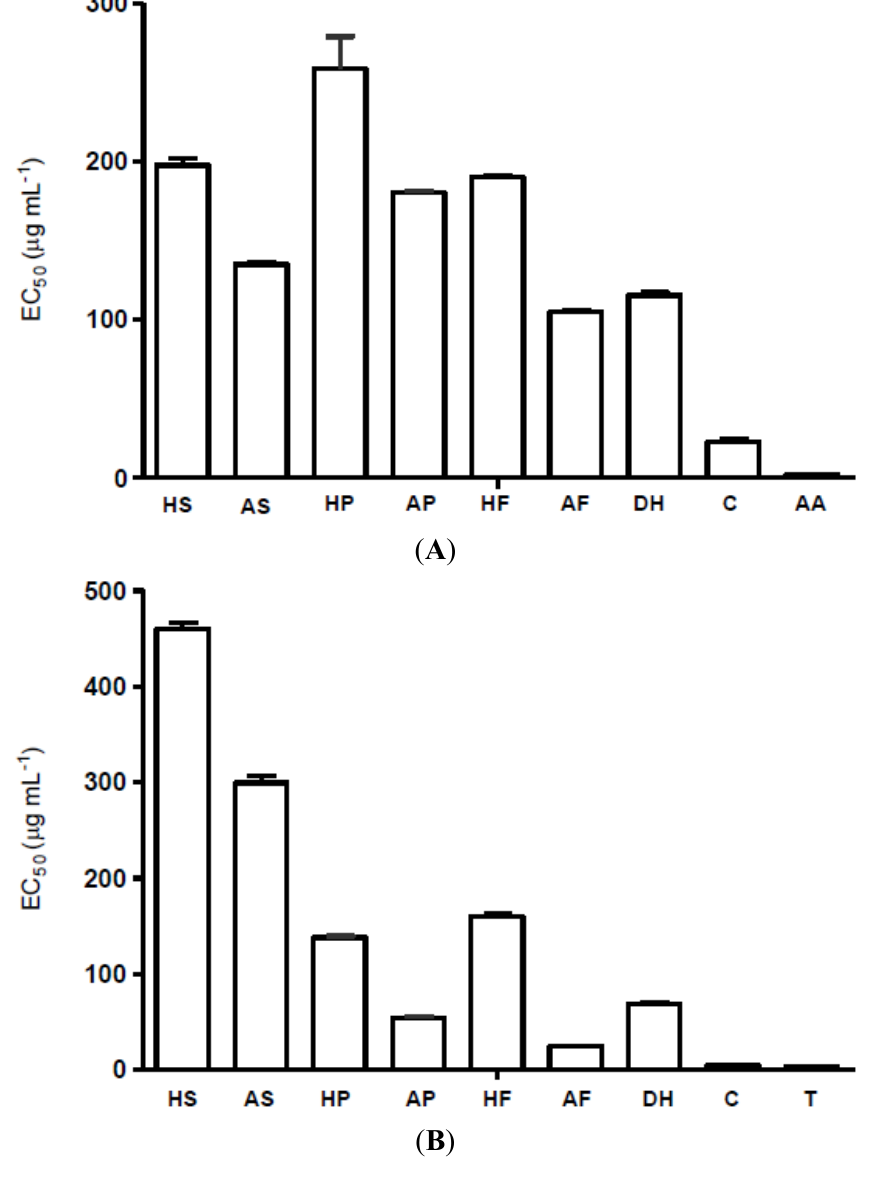
Figure 2. Effects of hexane and acetonitrile extracts of C. frutescens , capsaicin and dihydrocapsaicin on DPPH radical ( A ), ABTS radical; ( B ) and β -carotene/linoleic acid assay at 60 min; ( C ). HS: hexane seeds, AS: acetonitrile seeds, HP: hexane peel, AP: acetonitrile peel, HF: hexane whole fruits, AF: acetonitrile whole fruits, DH: dihydrocapsaicin, C: capsaicin, AA: ascorbic acid and T: Trolox. The confidence interval was 95% ( p <